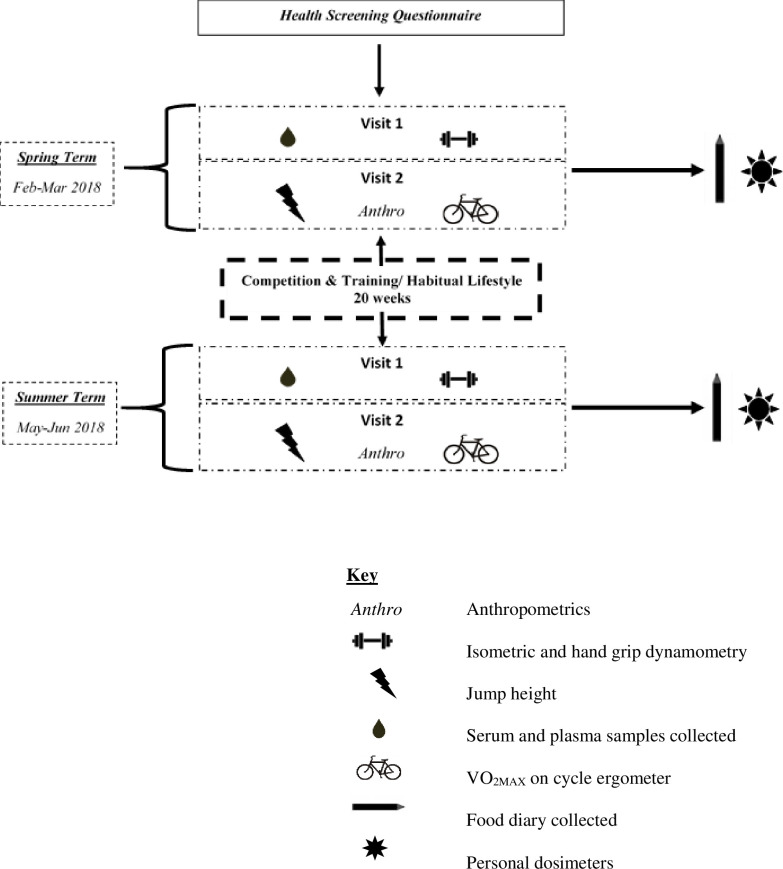
Schematic diagram of protocol.